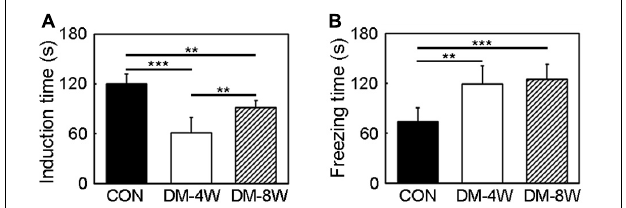
FIGURE 5 | Depression behavior increased indiabetic mice. (A) Bar graph of induction time of the control, DM-4W and DM-8W groupsin the tail suspension test. (B) Bar graph of freezing time of the control, DM-4W and DM-8W groups in the tail suspension test. Data are mean ± SD, n = 8 per group, ** p < 0.01, *** p <